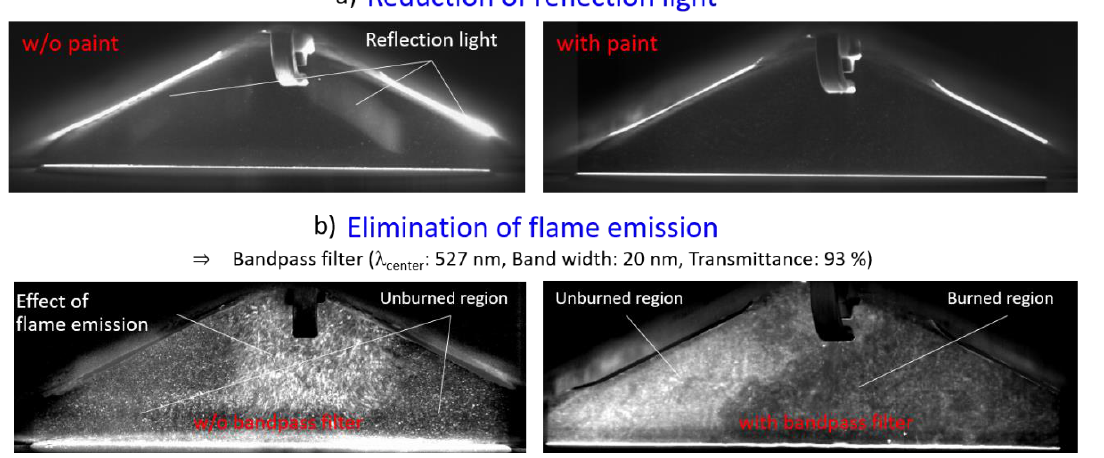
Figure 3. ( a ) Reducing reflection laser light during PIV measurement, ( b ) Avoiding the flame luminosity during combustion PIV measurement using band-pass filter.